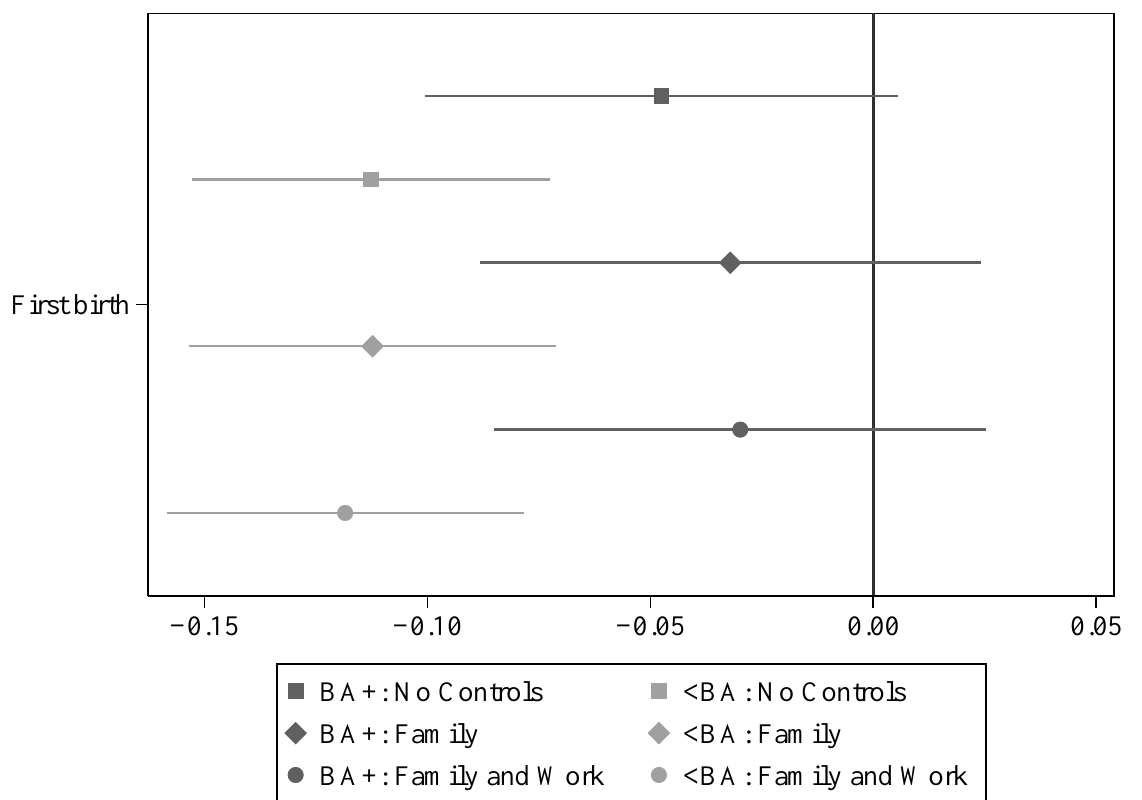
Figure 2: Coefficients across specifications, model 1: transition to motherhood. Coefficient estimates are from model 1 in Table 2 (“No Controls”), Table 3 (“Family”), and Table 4 (“Family and Work”). BA, bachelor’s